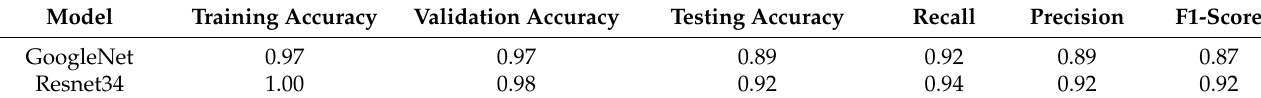
Table 2. Results of the GoogleNet and ResNet34 models.